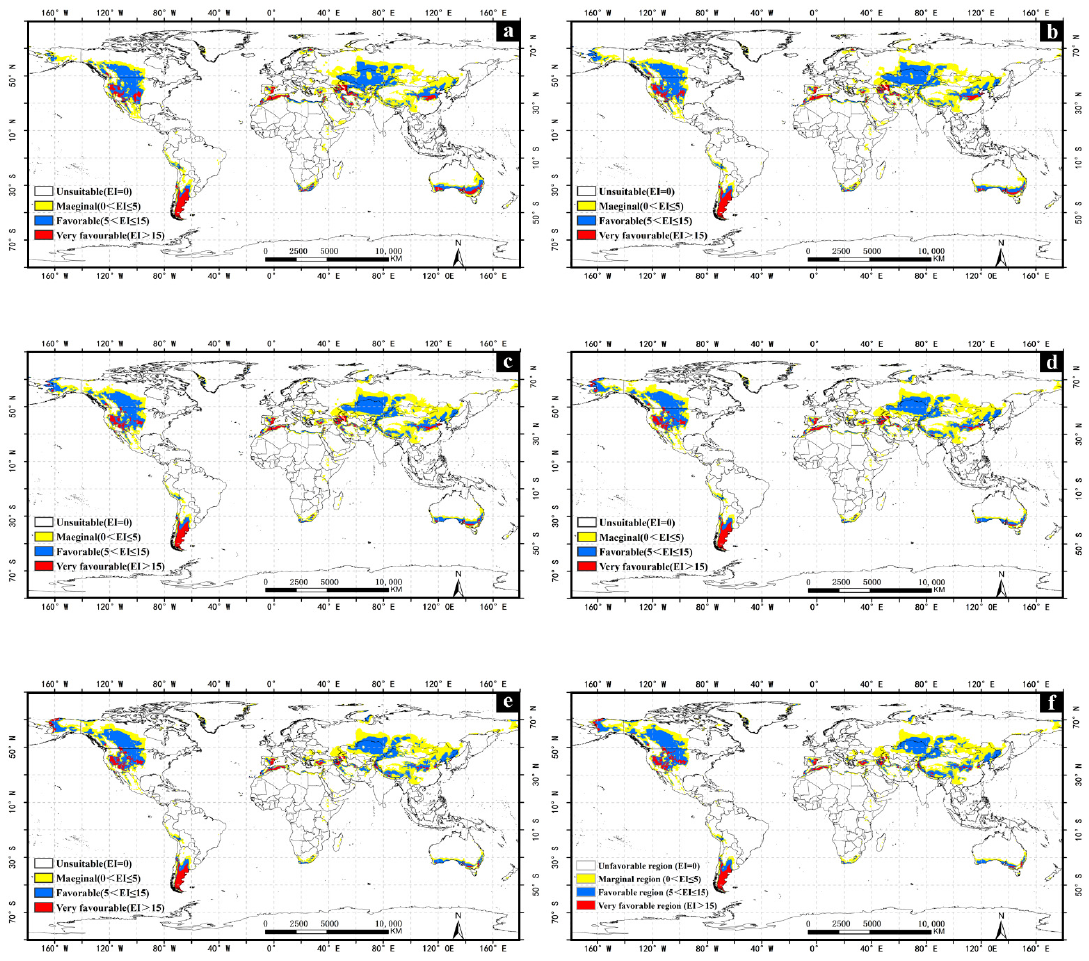
Figure 4. Potential global distribution of Apocheima cinerarius under future climate. ( a ) 2030; ( b ) 2050; ( c ) 2070; ( d ) 2080; ( e ) 2090; ( f ) 2100.